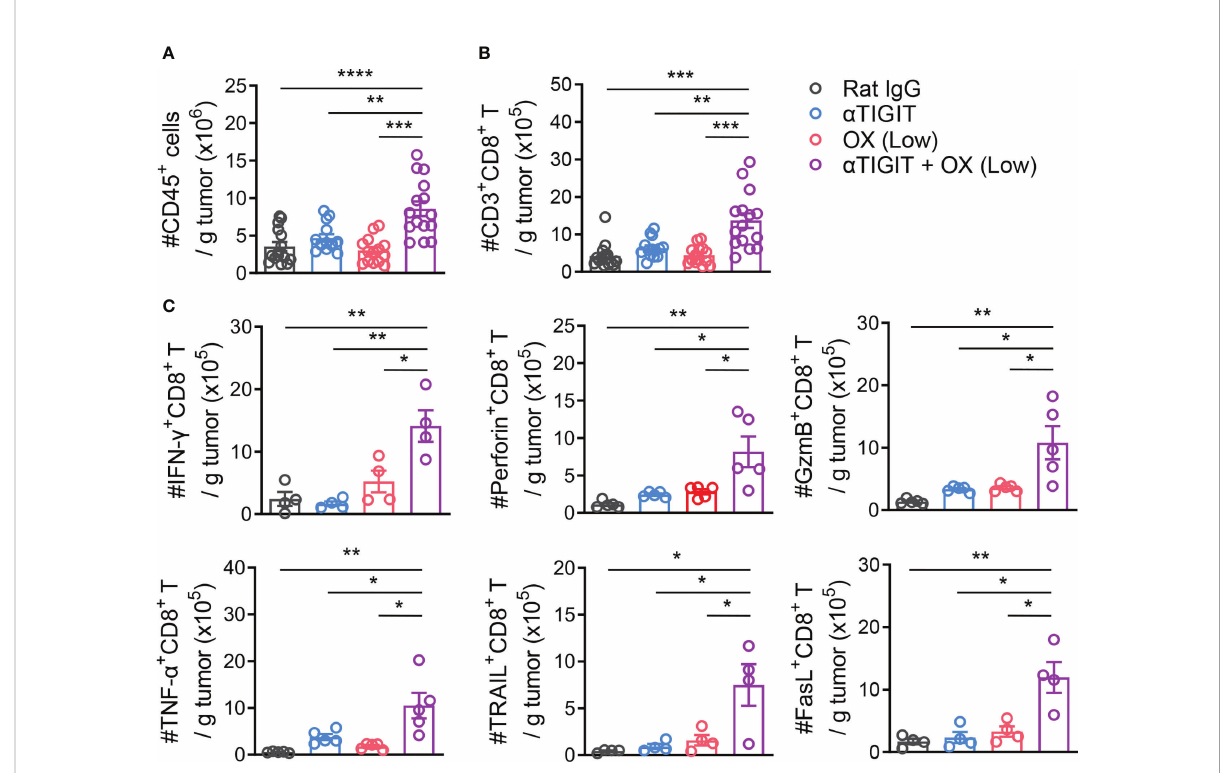
FIGURE 3 Combination treatment with Low-dose Oxaliplatin and TIGIT blockade Increases Tumor In fi ltration and Activation of CD8 + T Cells. (A) , CT26- bearing mice received various treatments or were left untreated. On day 21 after challenge, tumors were harvested and tumor-in fi ltrating lymphocytes were isolated. Absolute numbers of tumor-in fi ltrating CD45 + T cells were measured by fl ow cytometry. (B) , Absolute numbers of CD3 + CD8 + T cells measured by fl ow cytometry from mice as in (A) . (C) , Absolute numbers of tumor-in fi ltrating CD8 + T expressing IFN- g , Perforin, Granzyme B, TNF- a , TRAIL and FasL measured by fl ow cytometry from mice as in (A) . Each symbol represents an individual mouse. Data were representative of at least two independent experiments. Error bars represent means ± SEM. Statistical signi fi cance was determined using one-way ANOVA followed by Tukey ’ s multiple-comparisons (A – C) . *p < 0.05; **p < 0.01; ***p < 0.001 and ****p <